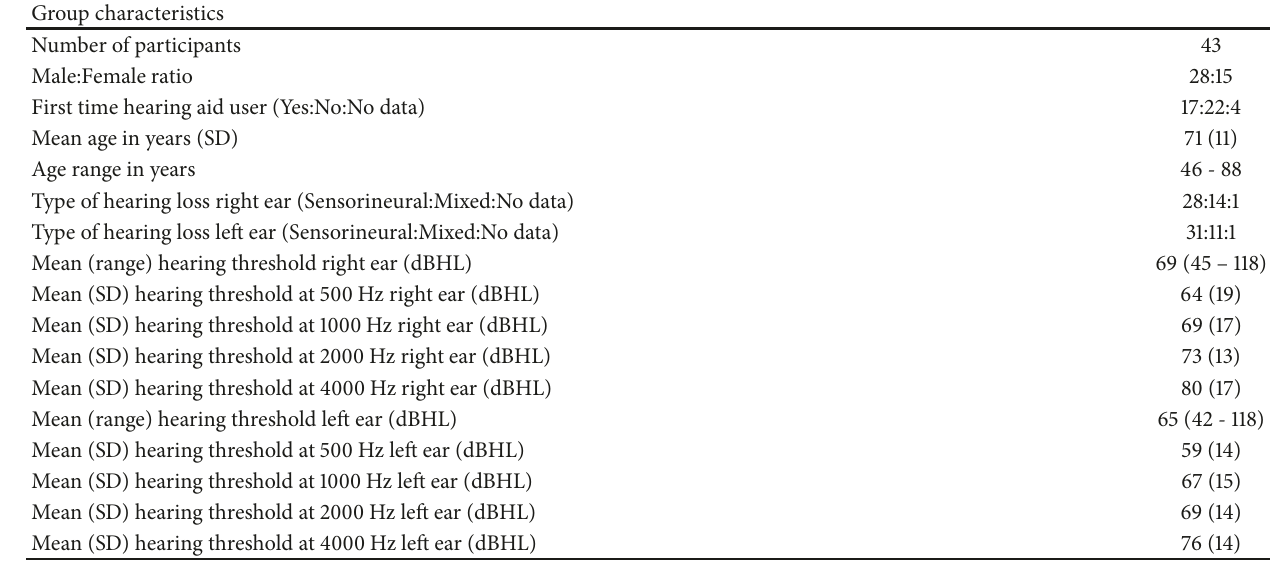
Table 2: Gender, age, and hearing thresholds of study